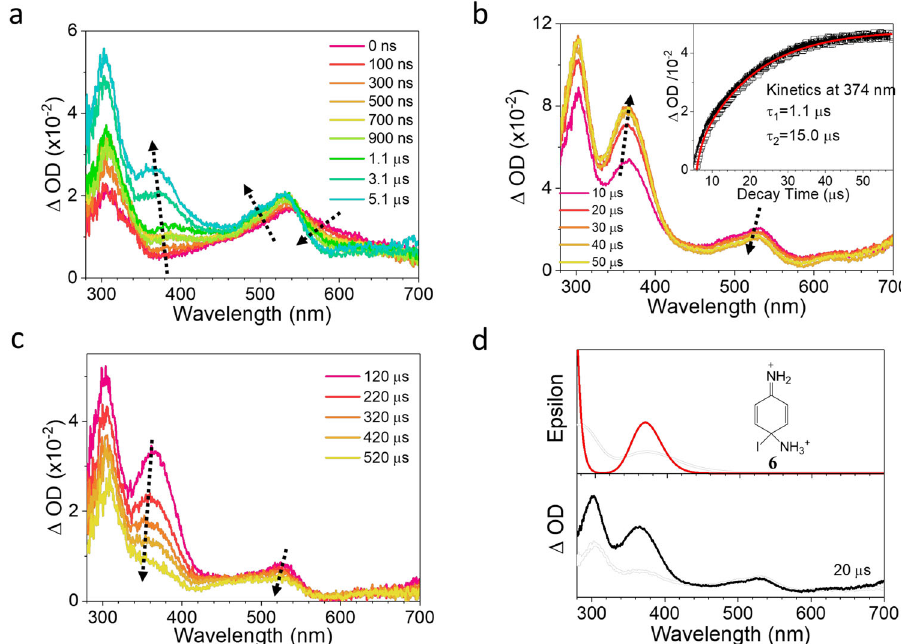
Fig. 4 Nanosecond transient absorption spectroscopy (ns-TA) spectra of the precursor 1 after 266 nm excitation in MeCN. a – c spectra obtained at different delay times, and the kinetics at 374 nm (gray square) with fi tting to the experimental data points (red solid line) was inserted in ( b ), ( d ) comparison between the TA spectrum at 20 μ s (bottom, black) and the predicted UV – vis spectrum of dication 6 (top, red and with the structure shown) using TDDFT/M06-2X calculation. The Cartesian coordinates of the computed structures are shown in the Supplementary Data